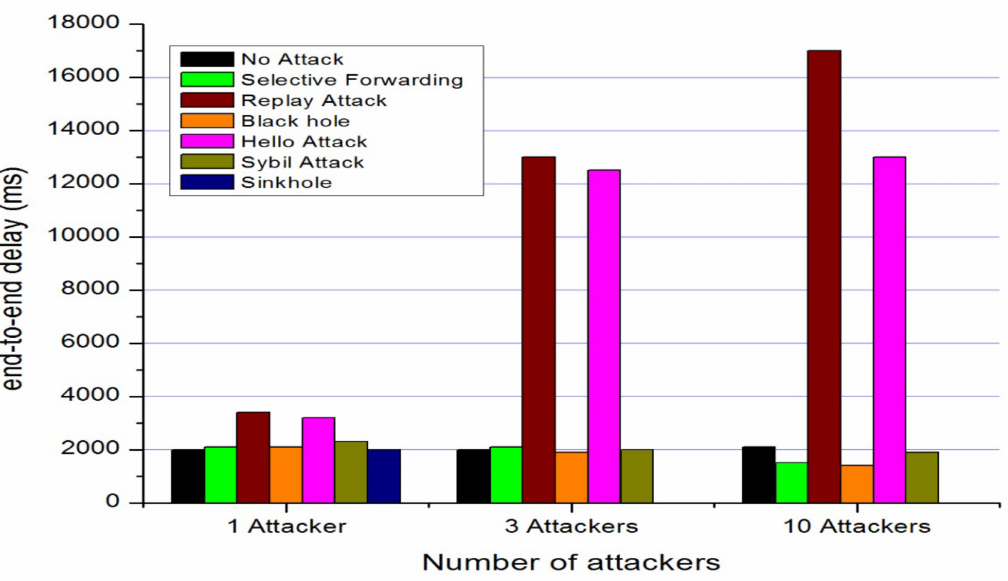
Figure 9. End-to-end delay vs. no. of